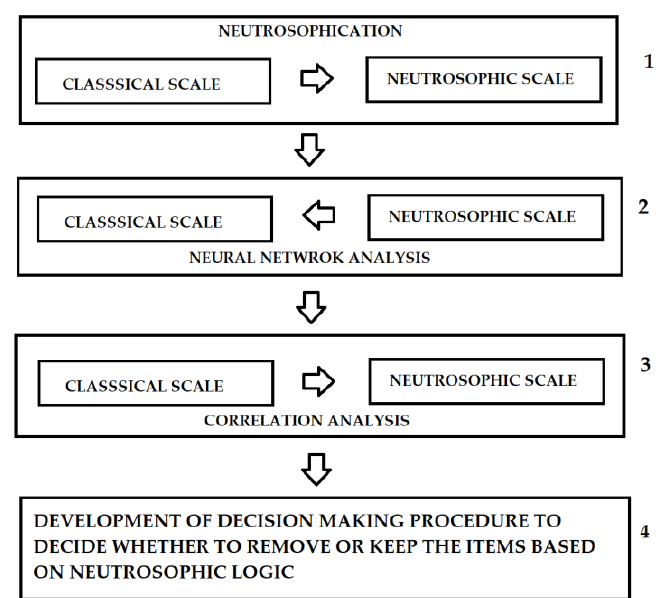
Fig. 9. The procedure for the development of neutrosophic scale.